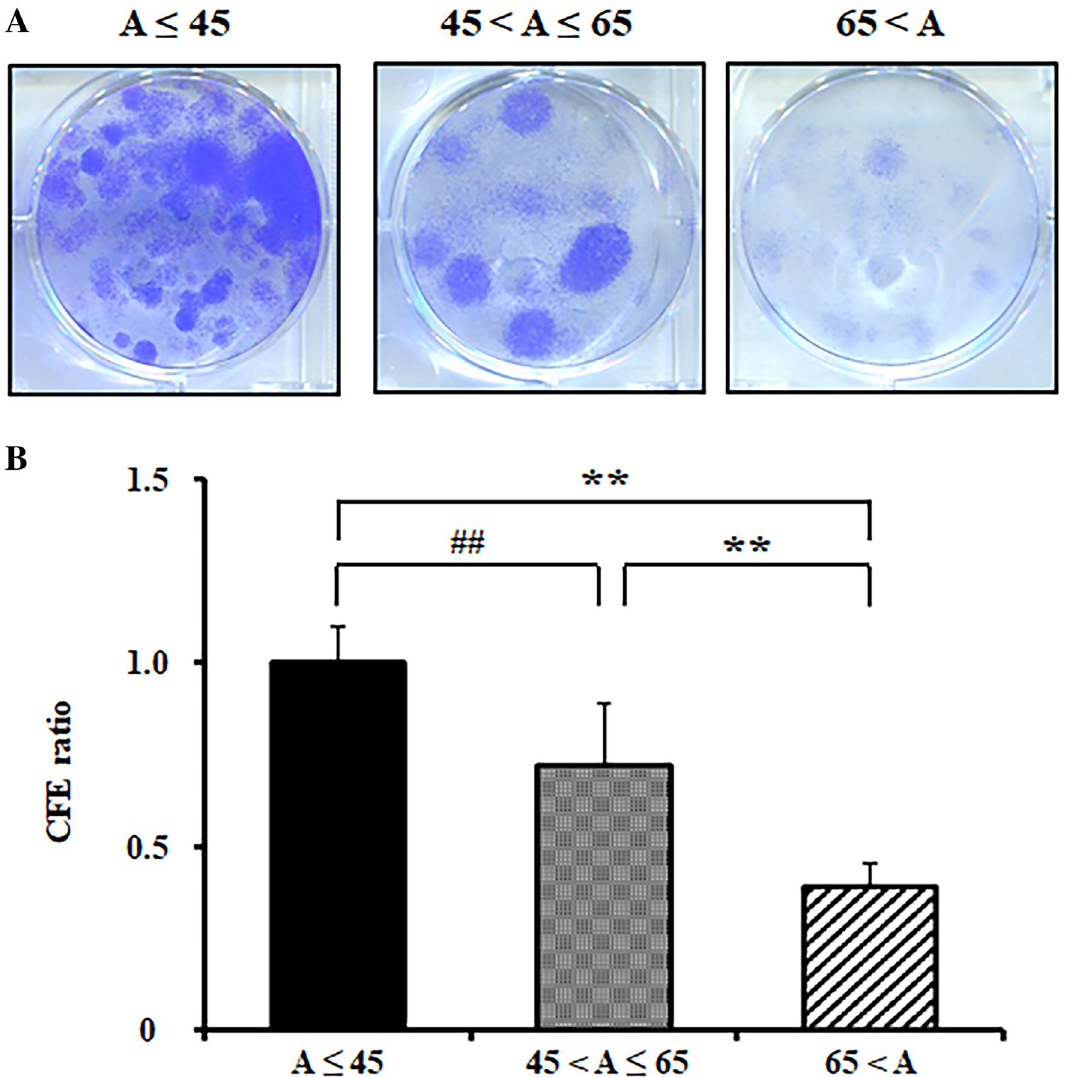
forming efficiency (CFE) ratio normalized to age ≤ 45. **p < 0.01 (vs. 65 < A), ## p < 0.01 (vs. 45 < A ≤ 65), n = 6 from 3